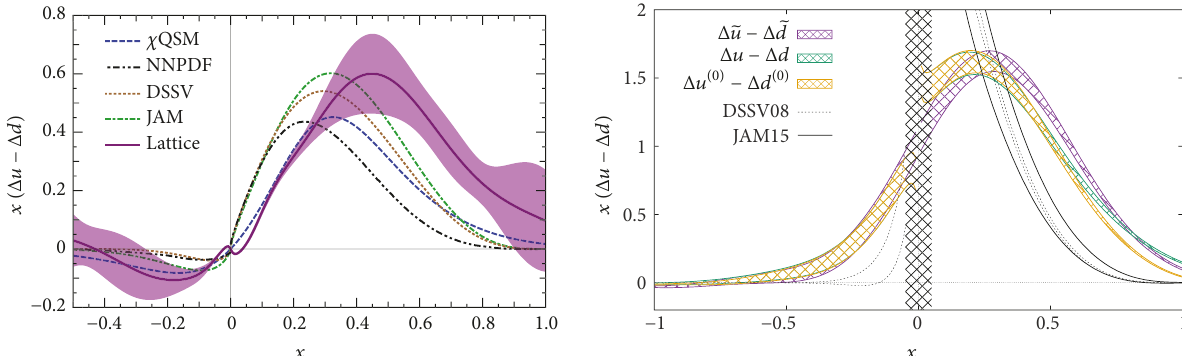
Figure 5: Final isovector helicity PDFs (shaded bands; 𝑥⋅ PDF in the left plot, PDF in the right plot) at the largest employed nucleon boost, left: Lin et al., 1.29 GeV, right: ETMC, 1.42 GeV. The right plot also shows the quasi-PDF and the matched PDF before nucleon mass corrections. For illustration purposes, also selected phenomenological parametrizations/models are plotted (left: dashed/dotted lines, no uncertainties shown, right: unfilled black bands representing uncertainties) [206–209]. The errors are only statistical. Source: left: [107], reprinted with permission by the Authors (article available under CC BY), and right: [108], reprinted with permission by the Authors and the American Physical